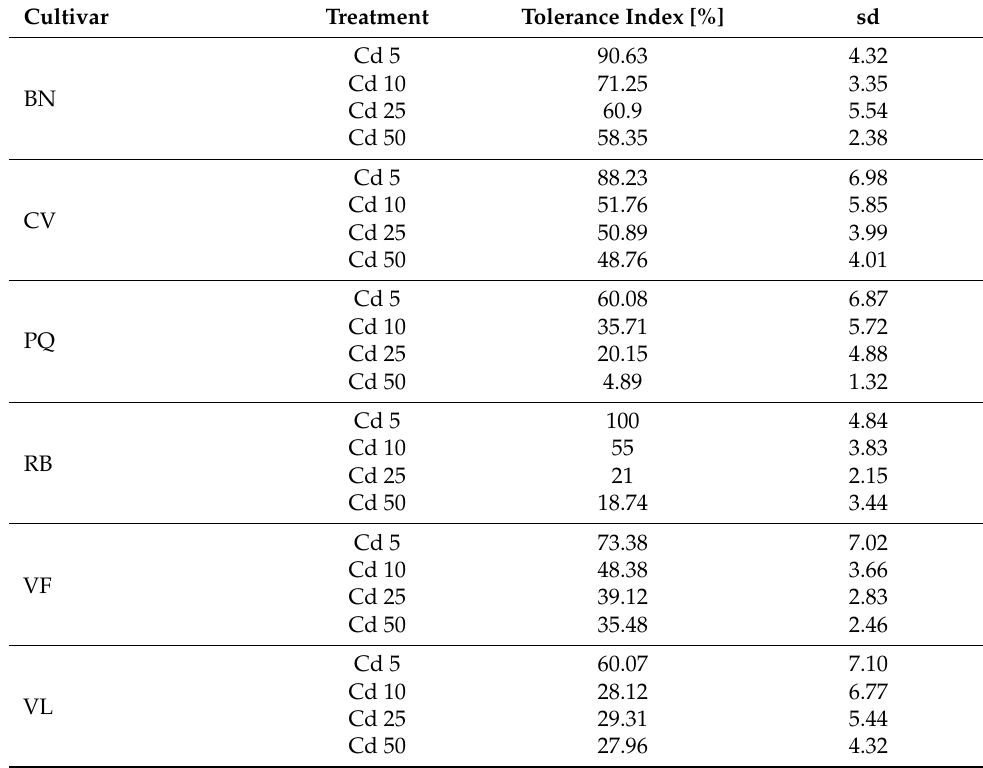
Table 1. Tolerance index and standard deviation (sd) for the six investigated eggplant cultivars. Cultivar